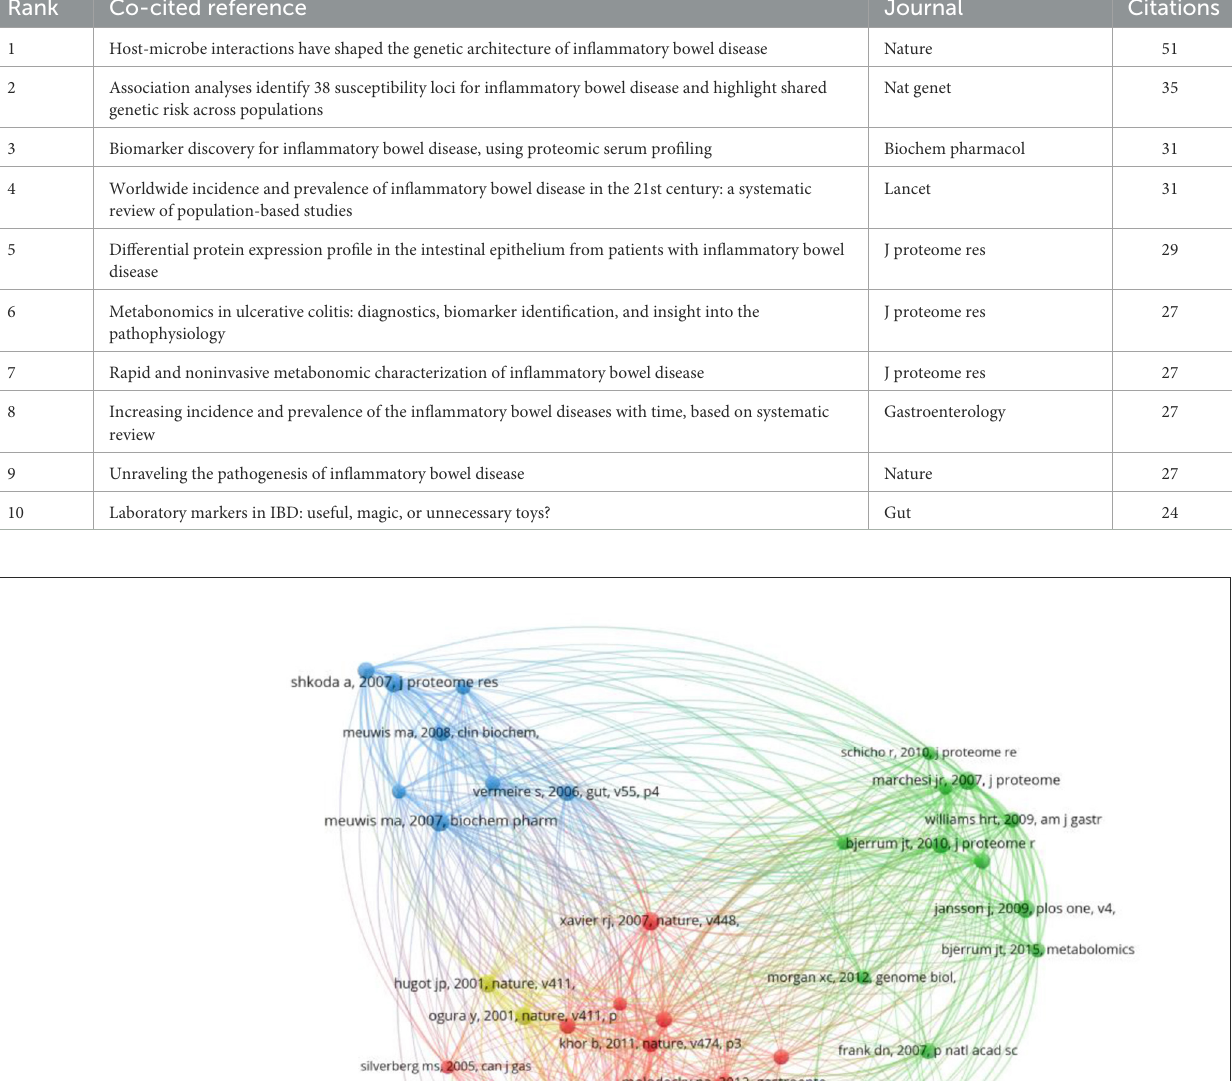
inflammatory bowel disease (32). Jacob Tveiten Bjerrum is interested in the research of characterizing ulcerative colitis by metabonomics. For example, one of his publications is “ Metabonomics of human fecal extracts characterize ulcerative colitis, Crohn’s disease and healthy individuals ” (33). Marie-Alice Meuwis has paid attention to proteomics studies of